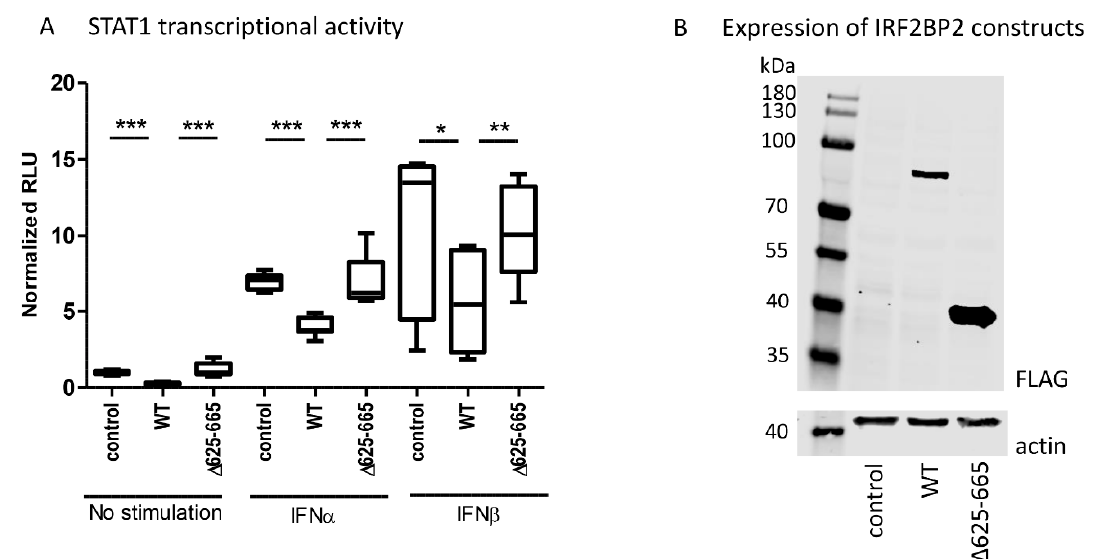
Figure 3. ( A ) The effect of wild-type IRF2BP2 and IRF2BP2 ∆ 625-665 on STAT1 transcriptional activity was studied using the ISRE-Luc reporter in HEK293T cells. ( B ) Detection of wild-type IRF2BP2 and IRF2BP2 ∆ 625-665 expression in HEK293T cells by immunoblotting. Statistical analyses were performed on three independent experiments, and Student’s two-tailed T-test was used to calculate significant differences. Significant differences are marked with an asterisk: * p ≤ 0.05, ** p ≤ 0.01, p *** ≤ 0.001. IFN; interferon, IRF2BP2; interferon regulatory factor 2 binding protein 2, RLU; relative luciferase unit, STAT; signal transducer and activator of transcription.